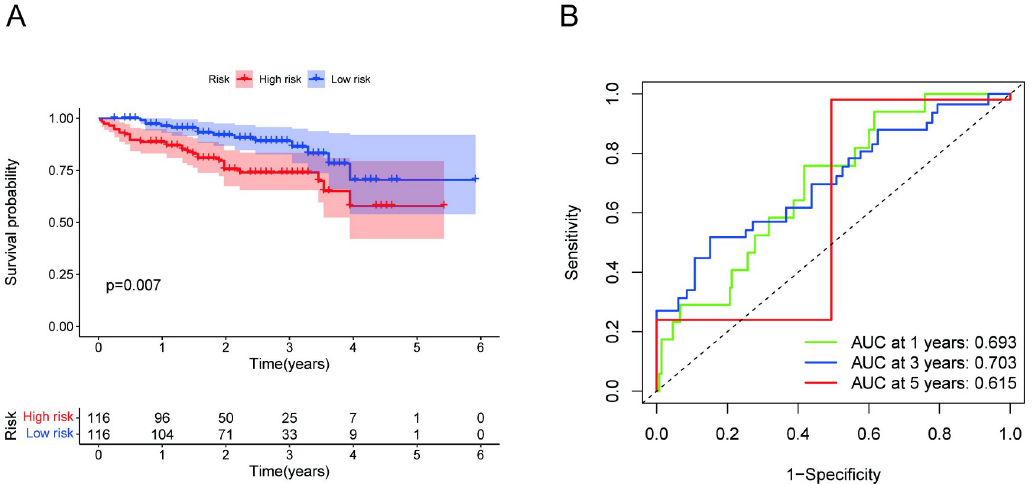
Fig 6. Validation based on the ICGC dataset. (A) Kaplan-Meier survival curves of patients in each group in the validation set. (B) ROC curves of 1-, 3-, and 5-year OS of patients in the validation